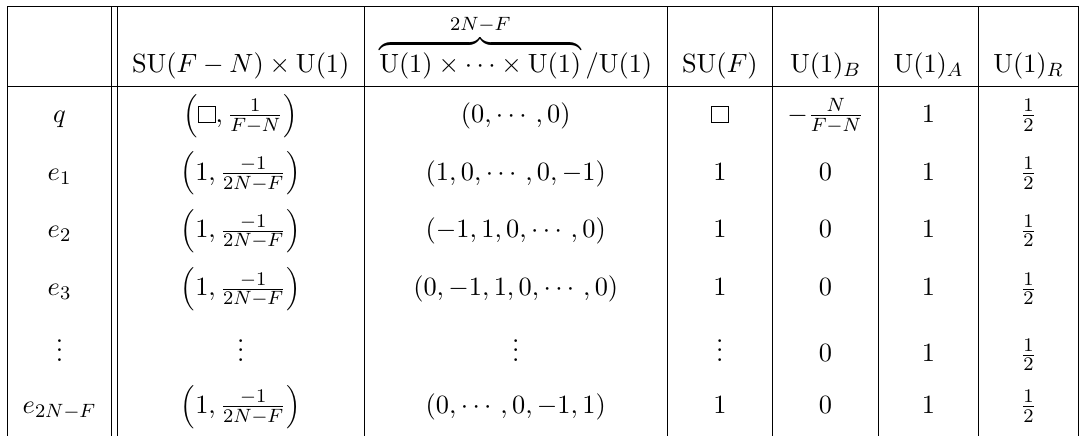
Table 4 . The charge assignment of the low-energy magnetic massless fields. In the third column, the sum of the U(1) gauge fields does not couple with the matter sector and should be removed. The table only lists the chiral multiplets and the corresponding anti-chiral multiplets are implicit.